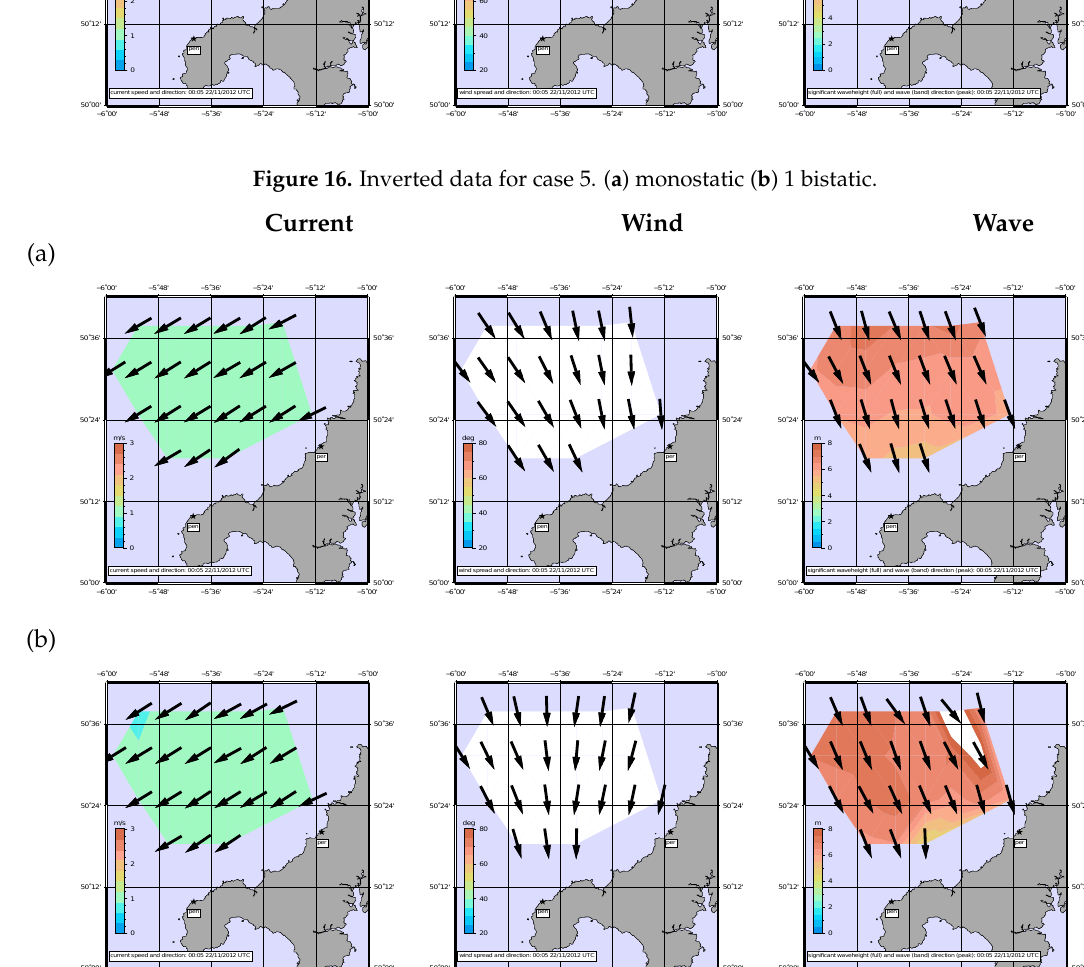
Figure 17. Inverted data for case 6. ( a ) monostatic ( b ) 1